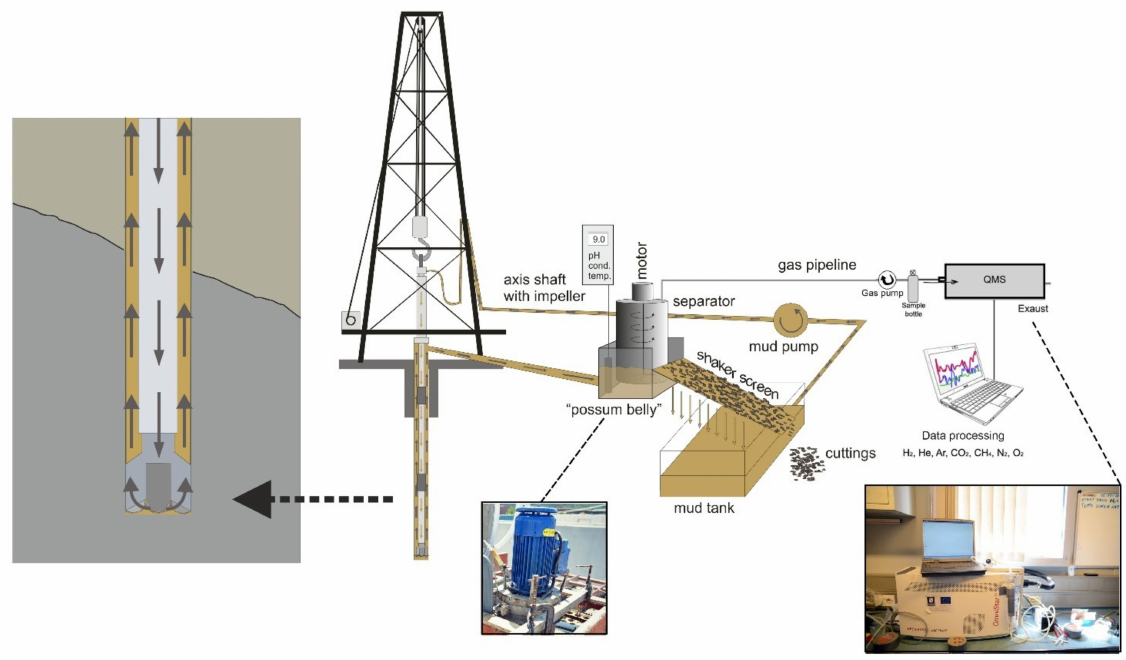
Figure 2. Sketch of the experimental setup. Gases entering the borehole are transported to the surface, together with the drill mud. A degasser extracts the gases from the drill mud. The gases are pumped to a lab trailer and analyzed in real time with a Quadrupole Mass Spectrometer